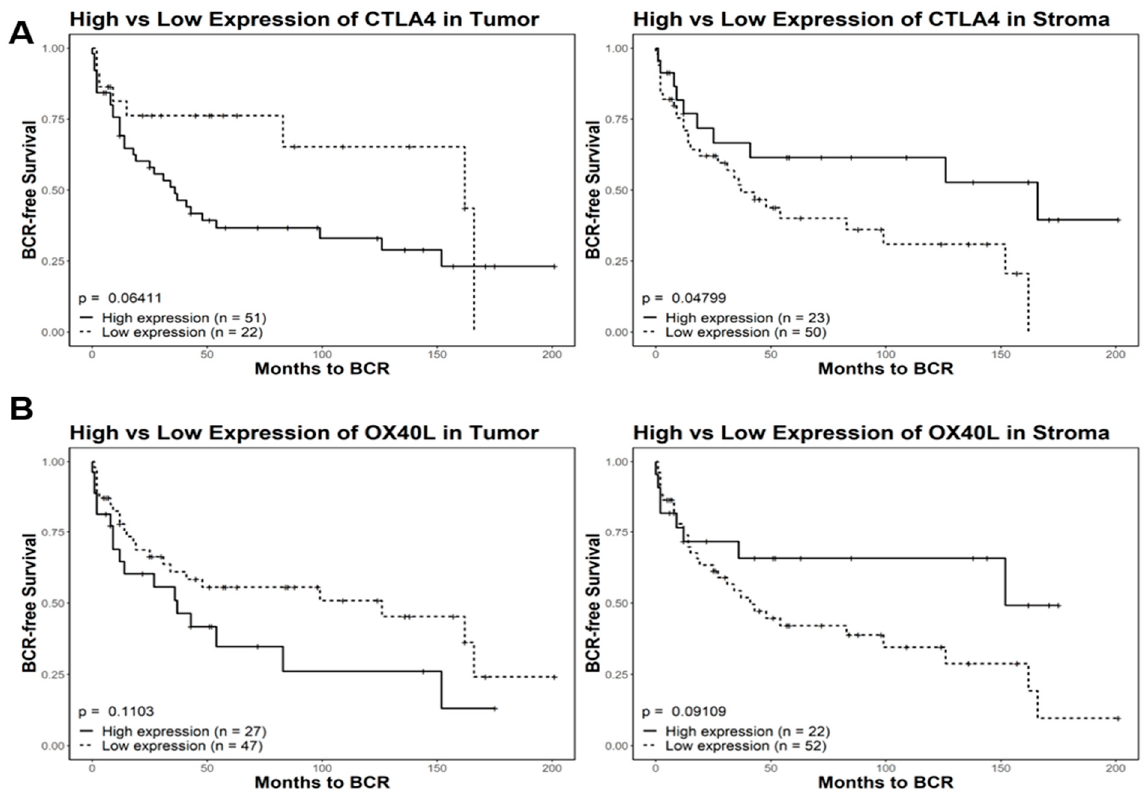
Figure 4. Kaplan–Meier survival analysis of CTLA4 and OX40L in tumor and tumor-adjacent stroma. Comparisons include high and low expression of CTLA4 ( A ) and OX40L ( B ). Quantized percent positivity from a series of TMA cores (n = 1547) was calculated using QuPath. Using a pretrained model, QuPath separated cells into determinants of either tumor or TAS tissue. This expression quantization was then provided as an input for Kaplan–Meier survival models. For both CTLA4 and OX40L, we identified significant differences in relation to biochemical relapse free (BCRF) survival in different tissue types. In tumor cells, high expression of CTLA4 was correlated with a lower overall BCRF survival. However, in tumor-adjacent stroma, high expression of CTLA4 was instead correlated with higher overall BCRF survival. These trends also held true for OX40L expression in both tumor and tumor-adjacent stroma. TMA = tissue microarray; TAS = tumor-adjacent stroma. When TAS (ROI = 12) was compared to tumor epithelium (ROI = 12), 231 genes